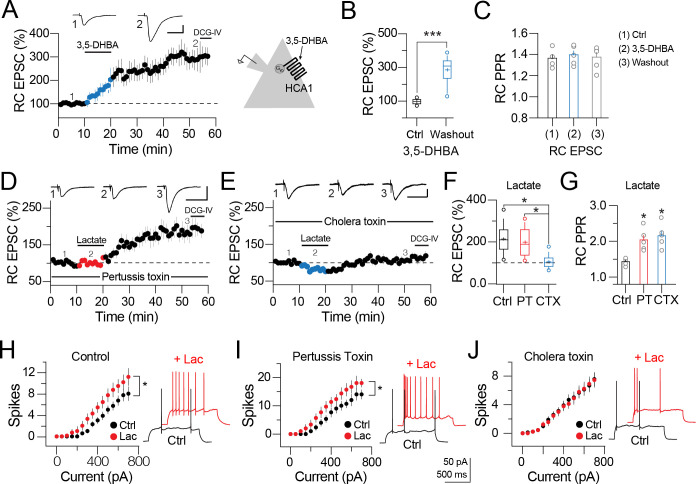
Synaptic potentiation involves activation of Gs proteins.A) Averaged time course and representative traces acquired at the indicated time showing the effects of 3,5-DHBA (0.5 mM) on the RC EPSC. Blue symbols represent 3,5-DHBA perfusion (10 min). B) Boxplots summarizing the magnitude of synaptic potentiation induced with 3,5-DHBA at 35 min of lactate washout. C) RC PPR analysis during baseline (1), perfusion of 3,5-DHBA (2), and at 35 min washout (3). D) Averaged time-course graph and representative traces acquired at the indicated time showing the effects of intracellular dialysis of pertussis toxin (PT, 100 ng/ml) and lactate perfusion (red symbols). E) Averaged time-course graph and representative traces from cells intracellularly loaded with cholera toxin (CTX, 2.5 μg/ml). CTX abolished the synaptic potentiation when lactate 2 mM was perfused (blue symbols). The synaptic responses from cells loaded with PT or CTX were insensitive to the application of DCG-IV 5 μM (solid bar on the time-course graphs). F) Boxplots summarizing the change on the RC EPSC amplitude during lactate perfusion in control, and in cells loaded with pertussis toxin or cholera toxin (red and blue boxes, respectively). G) RC PPR analysis in control conditions (solid bar), during lactate perfusion in cells loaded with pertussis toxin (red bar) or cholera toxin (blue bar) (One-way ANOVA on ranks, Tukey, *p<0.05). H–J) Scatter plots showing number of action potentials (spikes) elicited in response to current injections and the effects of lactate (2 mM) in control cells, cells loaded with pertussis toxin or cholera toxin. Cholera toxin prevented the increased number of spikes in response to lactate perfusion (Two-ways ANOVA on Ranks, Tukey, *p < 0.05).